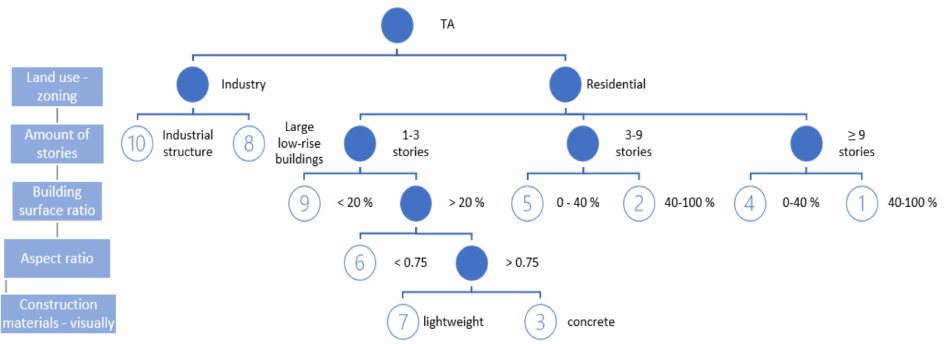
Figure 5. A flow diagram of the final stage of the method for assigning training polygons to their suitable LCZ